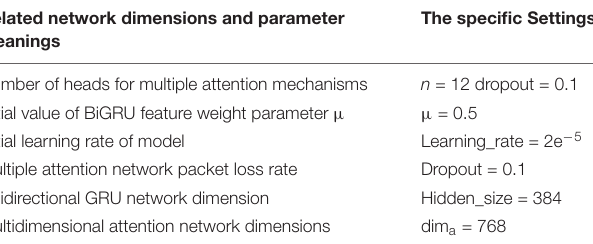
TABLE 1 | Parameter settings related to the model. Related network dimensions and parameter